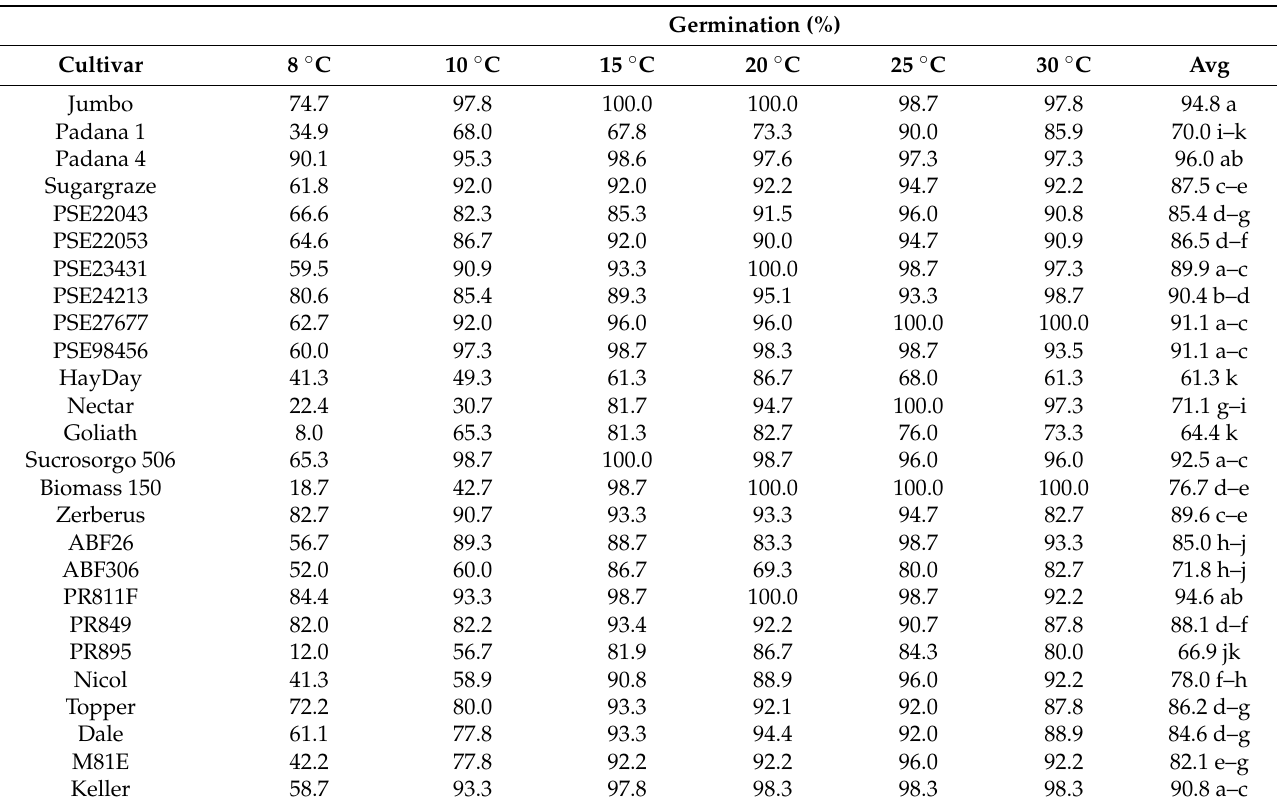
Table 2. Final germination percentage in sorghums in response to temperature. Values for the main factors (temperature and cultivar) followed by the same letter do not statistically differ at p ≤ 0.05 by LSD test.